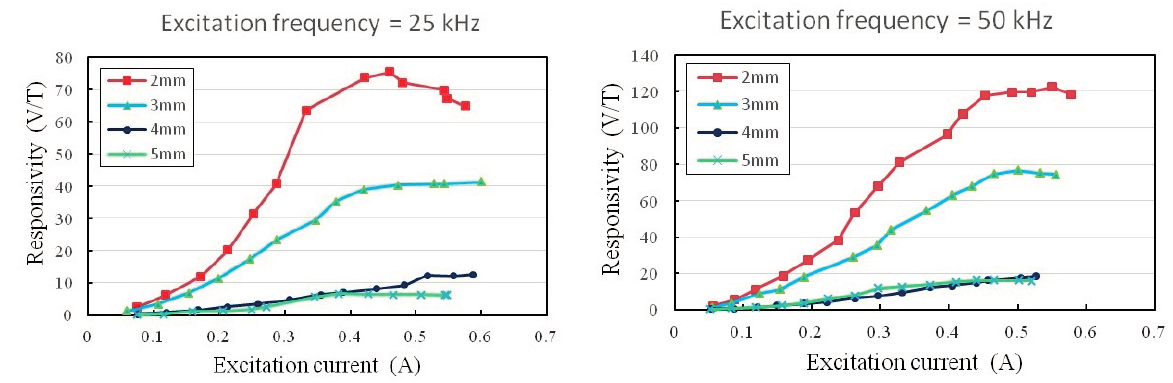
Figure 9. In-plane sensor responsivity (e.g., X-axis) vs. the excitation current at 25 kHz and 50 kHz,